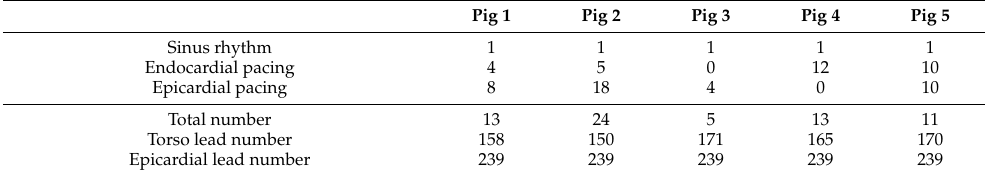
Table 1. Number of recordings from different pacing sites and recording leads. The first three rows showsthe number of recordings with different pacing sites or rhythms. The bottom two rows show the number of recording leads placed over the torso and epicardial surfaces.